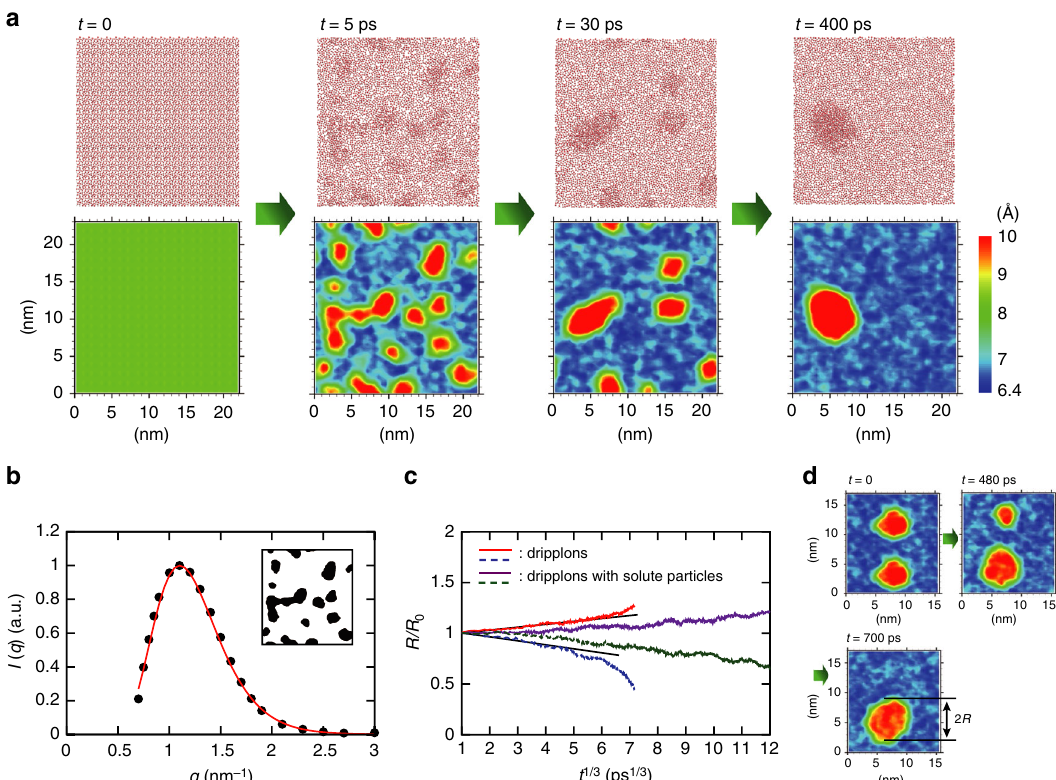
Fig. 3 Spinodal decomposition and osmotic stabilization of dripplons. a Time evolution of the top views of the water molecules between fl exible graphene sheets, starting from the homogeneous state at h = 0.85 nm. Each panel is accompanied by the distributions of gap between upper and lower fl exible graphene sheets. See also Supplementary Movies 1 and 2. b Radially averaged scattering intensity function of the binary image (inset) of dripplons at t = 5 ps; fi ve images from independent simulations are used for better statistics. The red curve shows a fi t with a log-normal distribution. c Time evolution of initially two identical dripplons; the radius R , normalized by the initial radius R 0 , is plotted as a function of t 1/3 . The corresponding gap distributions of initially two identical dripplons are shown in d . See Supplementary Movie 3 for the